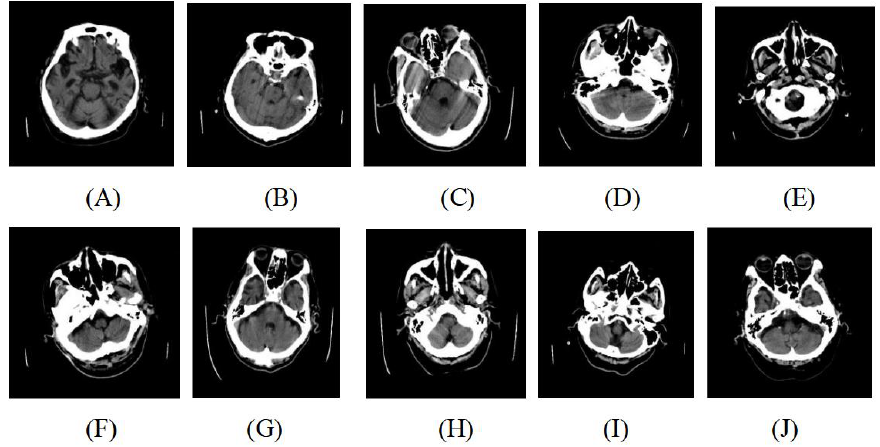
Figure 1. Illustration of original slices. ( A – E ) represent slices with motion artifacts. ( F – J ) represent slices without motion artifacts.